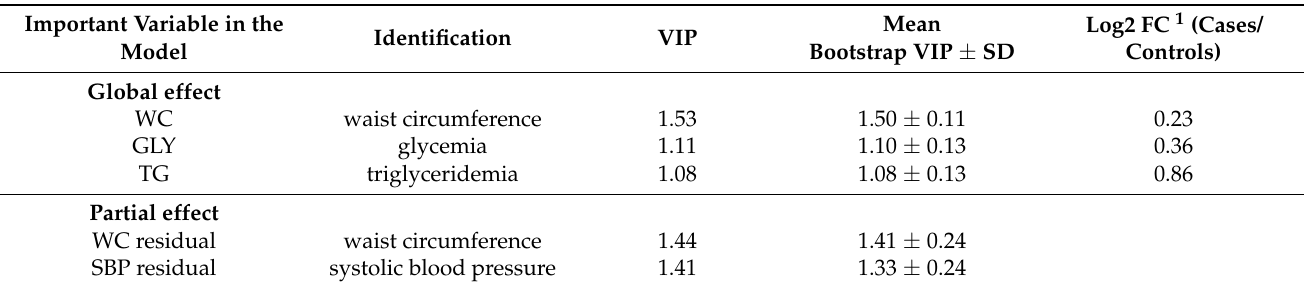
Table 2. Identifications, VIP and Log2 FC of the most important variables in the effects of Clinic on y in path